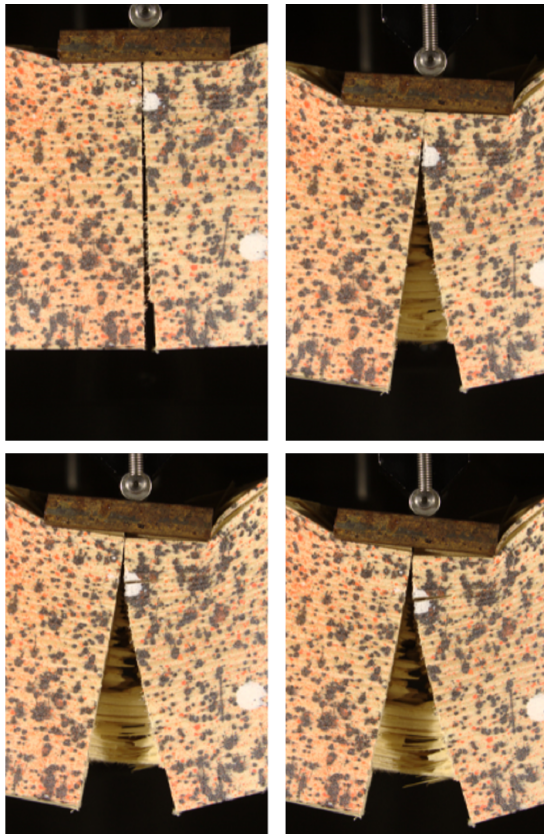
Figure 12. Damage evolution of the beam #09 with the failure F2 - splinter around the ligament and shear failure.